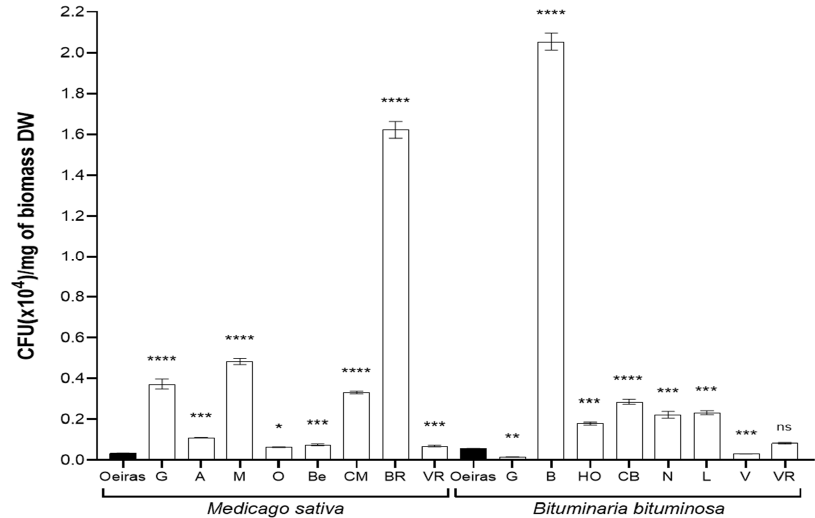
Figure 3. Total population of culturable microbiota isolated from Medicago sativa and Bituminaria bituminosa seeds. The bar graph indicates the culturable population recorded in the different locations from three independent experiments (n = 6) recorded in alfalfa (Medicago sativa) and pitch clover ( Bituminaria bituminosa ), collected in the natural locations. The ‘Oeiras’ location (in black), for both species, was considered a control representing a humid/semi-humid location in contrast with the rest of locations. The locations are abbreviated as follows: ‘G’, Guadix; ‘A’, Agost; ‘M’, Medinaceli; ‘O’, Orce; ‘Be, Belchite; ‘CM’, Castejón de Monegros; ‘BR’, Bárdenas Reales; ‘VR’, Vélez-Rubio; ‘B’, Baza; ‘HO’, Huércal-Overa; ‘CB’, Carril-Busot; ‘N’, Níjar; ‘L’, Lorca; and ‘V’, Vera. The sets of data were compared using a two-tailed Student’s t -test and 95% confidence intervals, where the asterisks represent a statistically significant difference at p < 0.05, *; p < 0.01, **; p < 0.001 ***; and p < 0.0001, ****; ns stands for statistically non-significant. Error bars represent s.d.